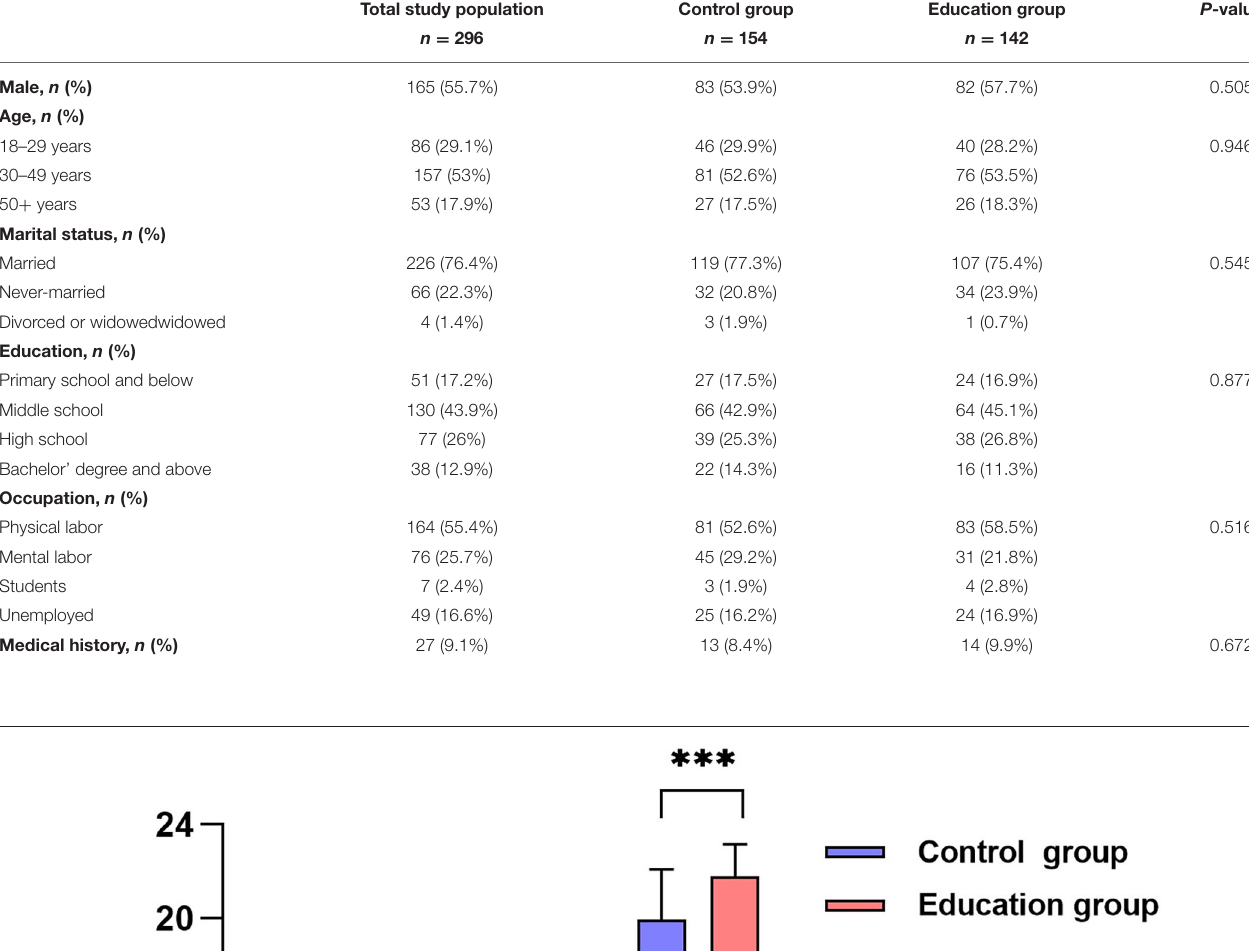
TABLE 2 | Baseline characteristics of residents included in this study.